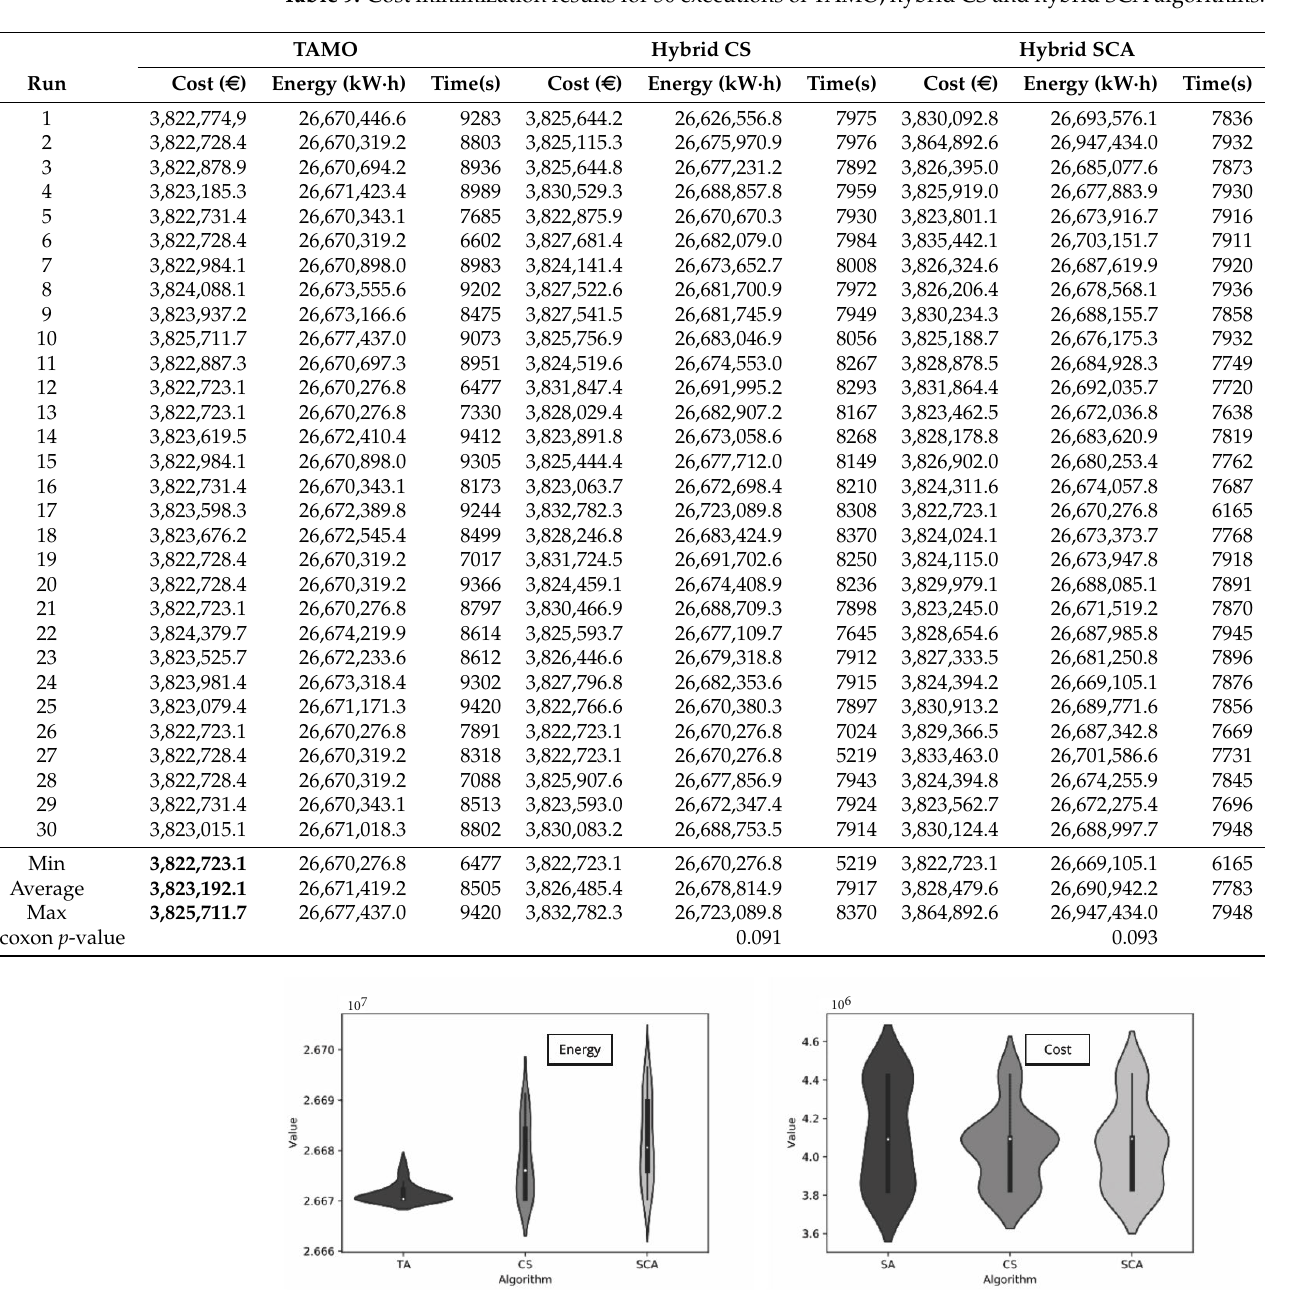
Figure 5. Embodied energy and cost result violin